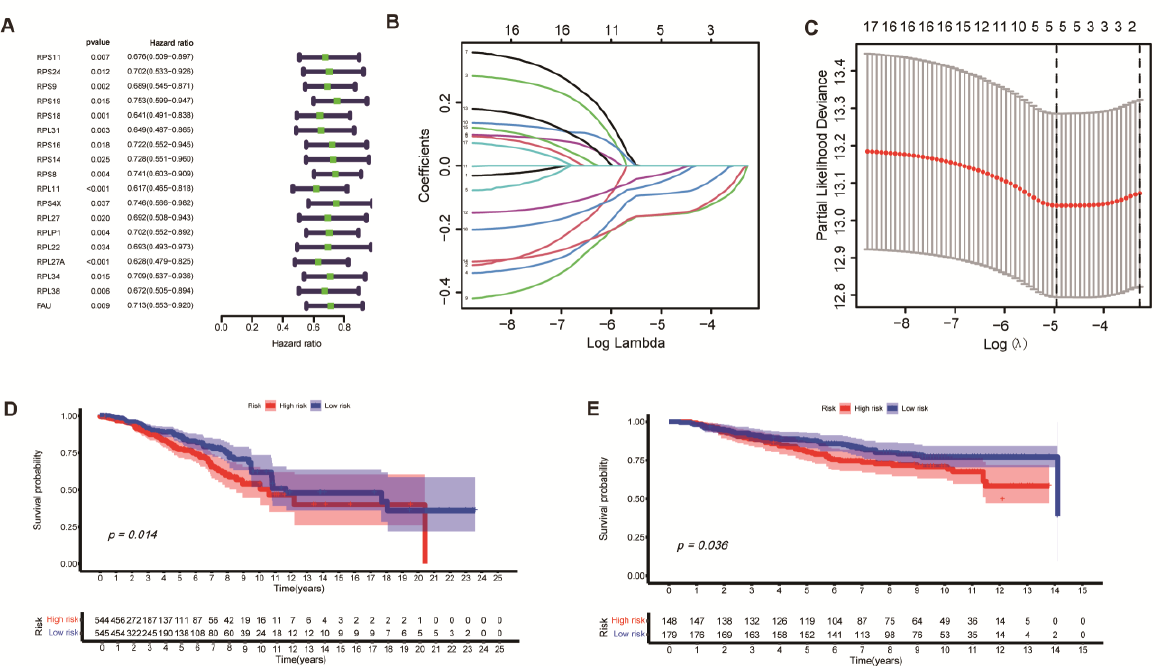
Figure 9. Development and validation of the ribosome-related signature (RRS) based on ribosome- associated clusters in TCGA cohort. ( A ) Univariate COX regression analysis of 34 ribosome-related genes, displaying 18 ribosome-related genes ( p < 0.05). ( B ) Five gene expression features based on ribosome related-clusters were selected with the LASSO Cox model. ( C ) Tuning parameter selection for ribosome-associated genes in the LASSO model in TCGA BC patients. ( D , E ) Kaplan–Meier survival curves showed lower survival rates for high-risk patients than low-risk groups in both the TCGA and GEO cohorts.